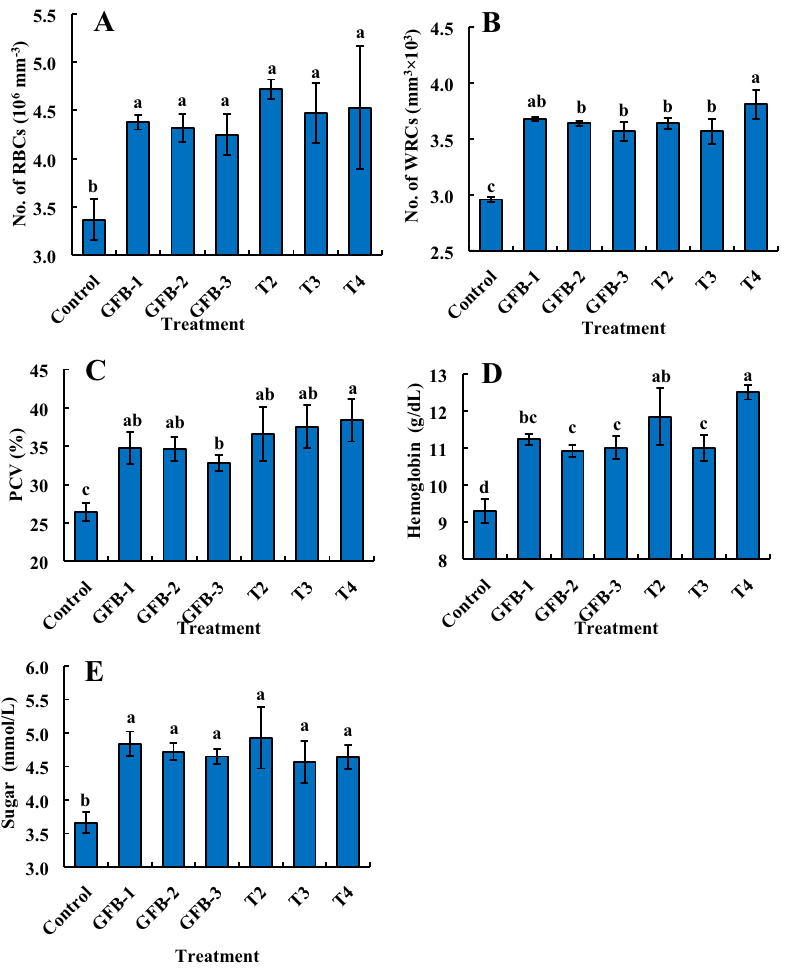
Figure 9. Comparative study between assessment of individual effects of five probiotic bacterial strains viz. GFB-1, GFB-2, GFB-3, GFB-4 and GFB-5 and consortium effects of five bacterial strains viz T2, T3 and T4 isolated from the gut of B. gonionotus on hematological parameters (A, B, C, D and E) of the host fish. One way ANOVA was performed for analyzing the data of three replicated experiment and data in column varies significantly in LSD at P < 0.05 (Statistix 10). Different letter bars indicate significant variations in RBC, WBC, PCV (%), hemoglobin and glucose of the host fish in different groups by the isolates at P < 0.05 (Statistix 10). Error bar = ± SD; n =